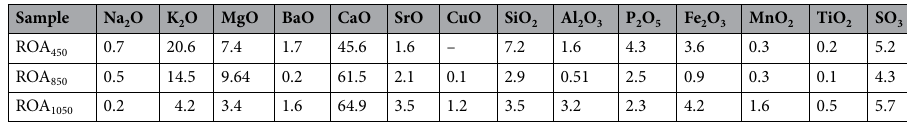
Table 2. Chemical composition of the WA from Russian olive in different combustion temperatures.